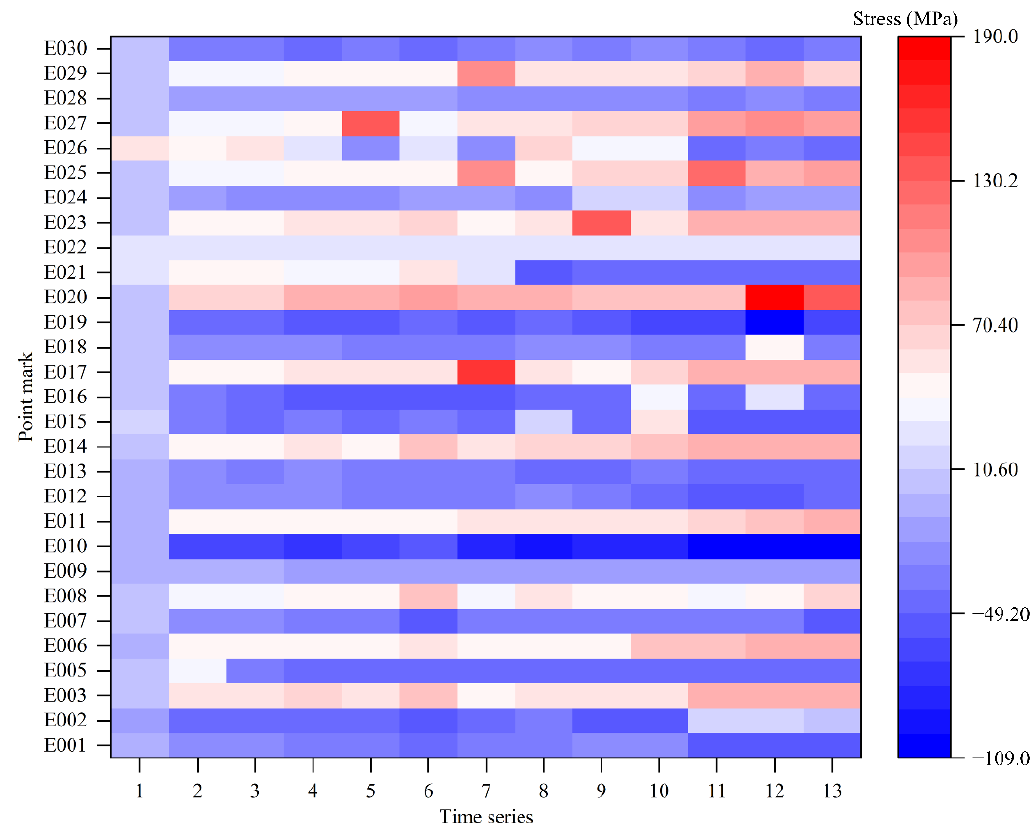
Figure 9. Monitoring data of each member.